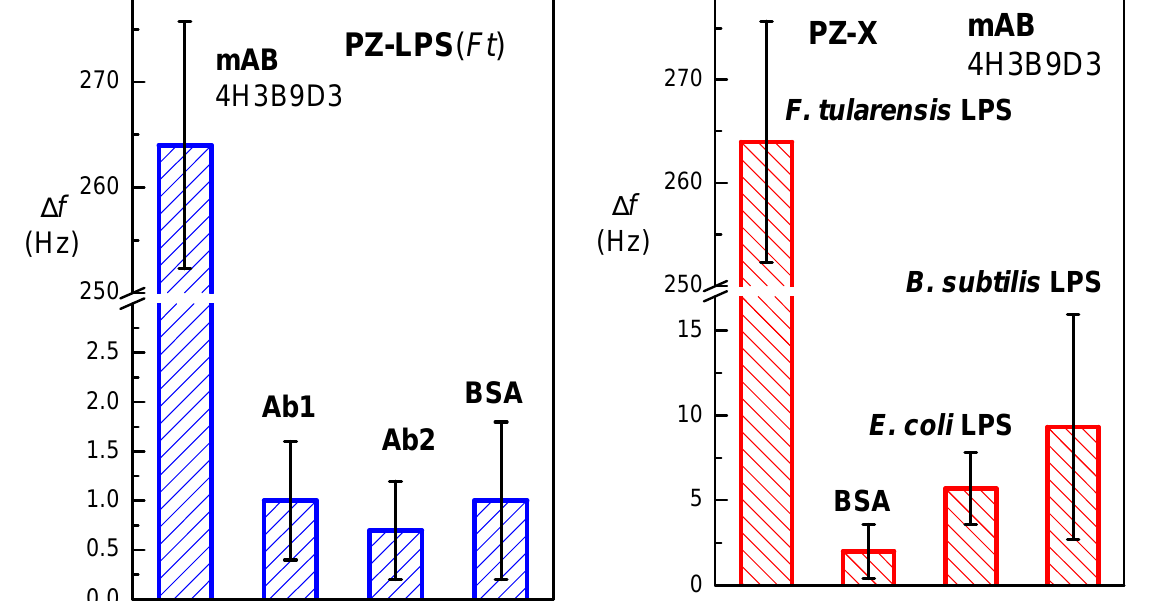
Fig. 3. Specificity of the piezoelectric sensor with immobilized LPS from F. tularensis (left, blue bars). The specific sample (100 m l) was the monoclonal antibody 4H3B9D3 diluted 1:10 (final protein concentration 0.67 mg/ml). As negatives controls, commercials antibodies anti-IgM (Ab1) and anti-IgG (Ab2) (both adjusted to the total protein 0.67 mg/ml) were used as well as BSA at 1 mg/ml. At right (red bars), specificity of the monoclonal antibody 4H3B9D3 (100 µl sample, protein concentration 0.67 mg/ml) was tested using piezoelectric immunosensors with immobilized LPS obtained from either F. tularensis , E. coli or B. subtilis , and also immobilized albumin (BSA) was used. The error bars indicate estimated standard deviations (n =